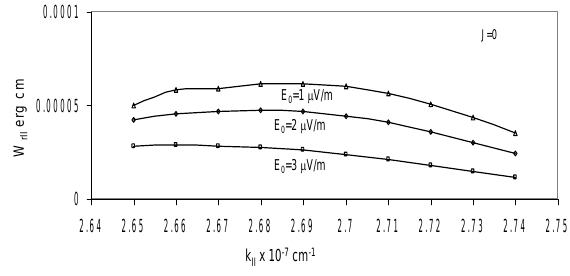
Fig. 10. Variation of parallel resonant energy Wr II erg cm versus wave vector k II cm − 1 for different values of parallel electric field Fig.10 Variation of parallel resonant energy Wr II erg cm versus wave vector k II cm-1for different values of Fig:-7 Variation of parallel resonant energy W erg cm versus wave vector k II cm -1 for different values of parallel electric rII parallel electric field E 0 , and distribution index J = 0. E ,and distribution index J=0. field 0 E 0 , and distribution index J=0.